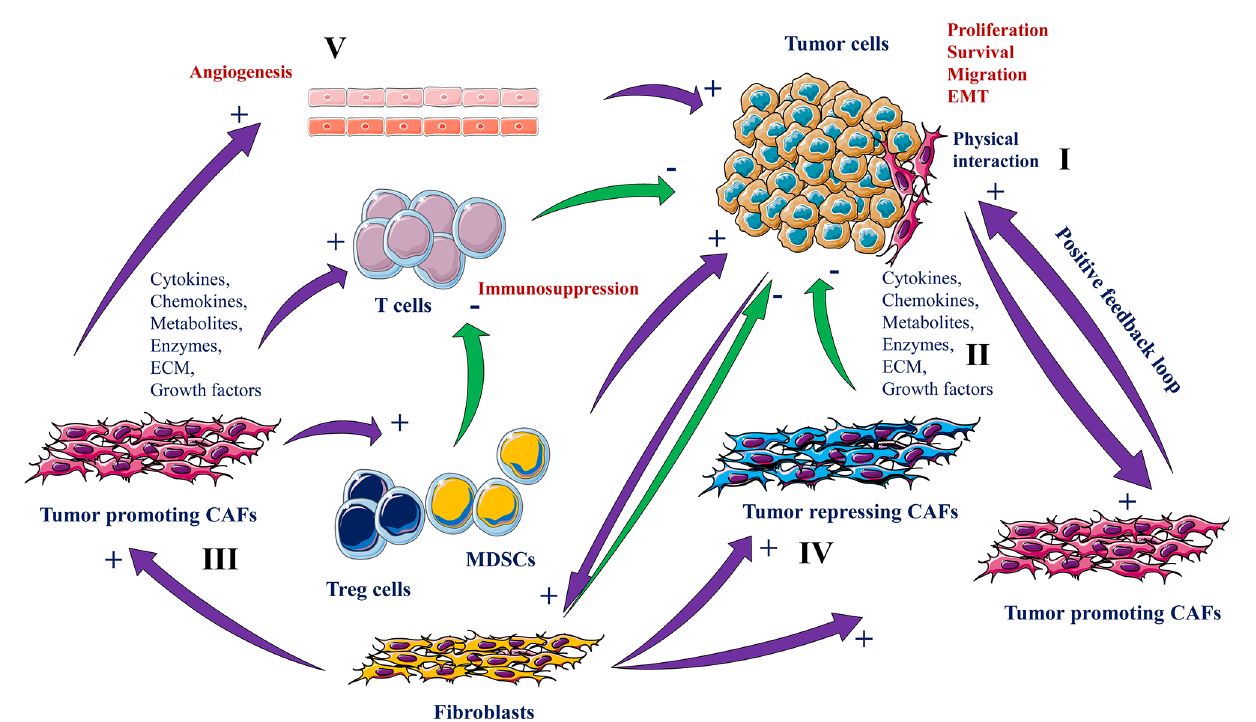
FIGURE 3 | Roles of CAFs and cancer cells interaction in tumorigenesis. CAFs derived from normal fi broblasts interact with tumor cells physically (I) or through secreted molecules and ECM remodeling (II) that either promotes (III) or suppresses tumorigenesis (IV). While the tumor-promoting CAFs participate in tumor cell growth, survival and migration, angiogenesis (V), EMT and immune cell activity repression, the tumor repressing CAFs and normal fi broblasts inhibit these